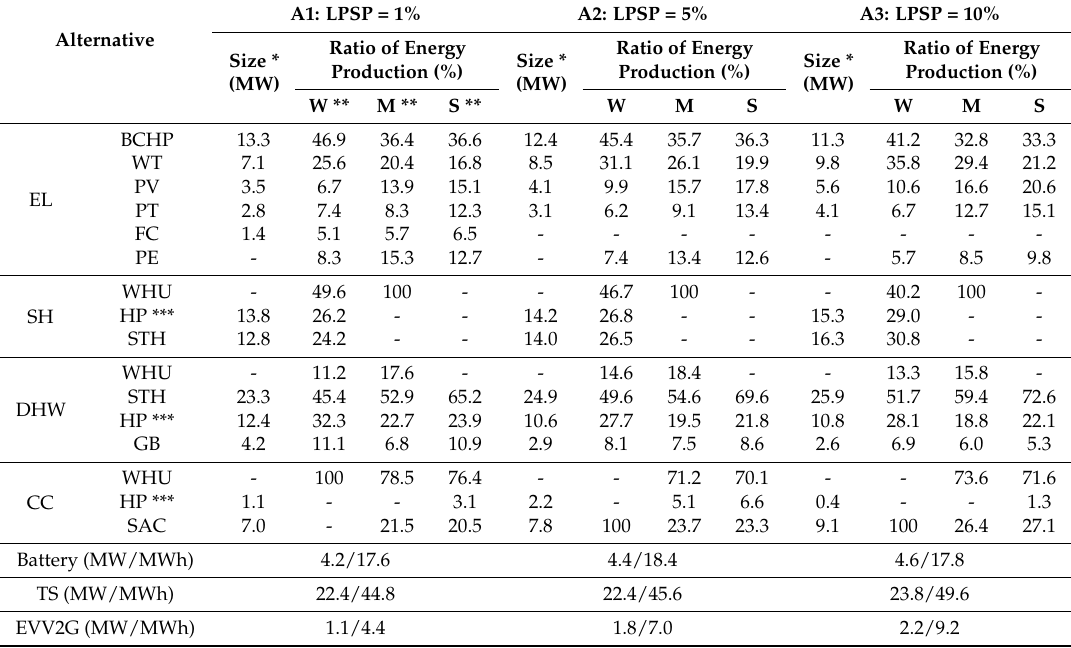
Table 5. Advanced optimal MENR system scenarios in Xizhou